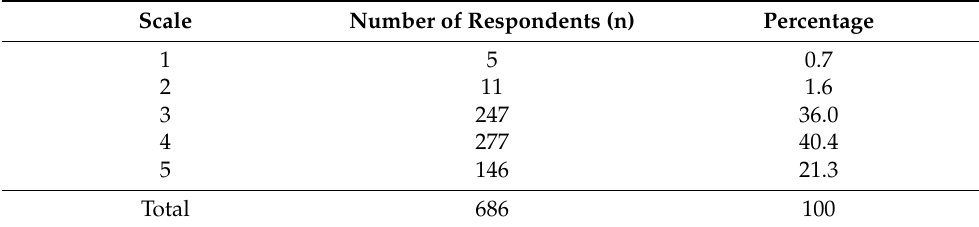
Table 5. How much have respondents played with their pets during lockdown compared with